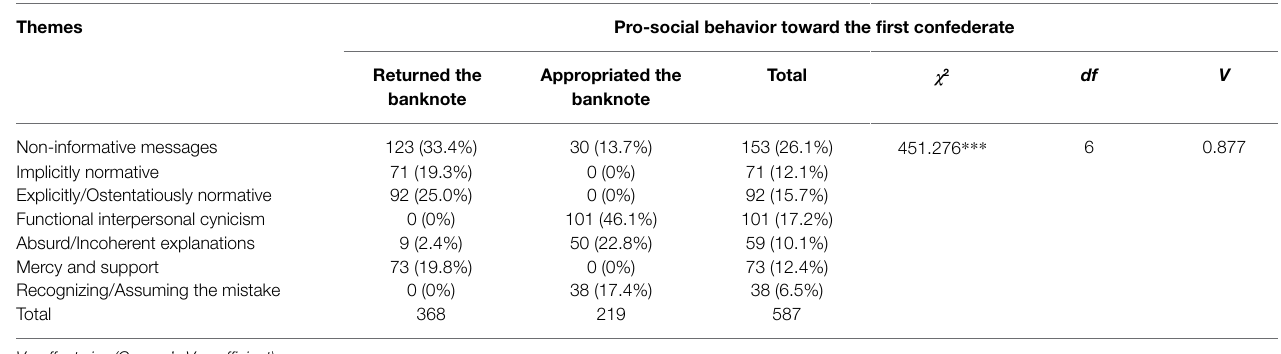
TABLE 5 | Cross-tabulation of pro-social behavior toward the first confederate and the themes generated during the post-experimental interview ( N = 587).